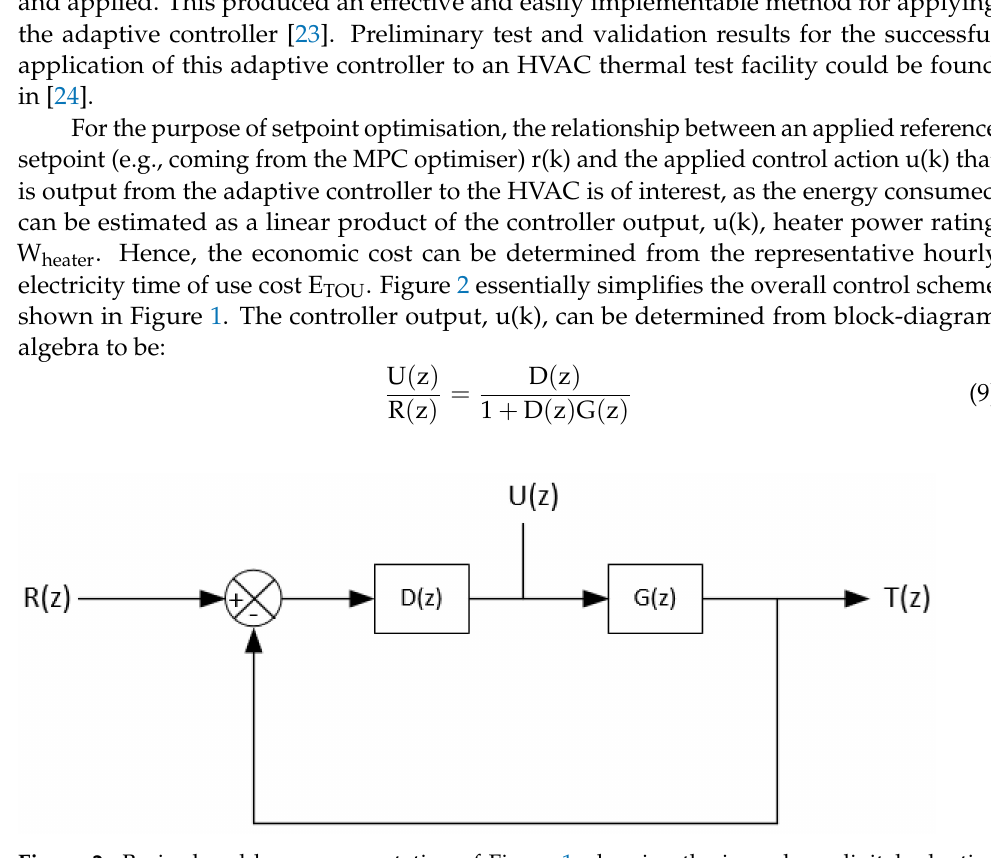
Figure 2. Basic closed loop representation of Figure 1, showing the inner loop digital adaptive controller D(z) and the controlled process G(z), where U(z) is the controller